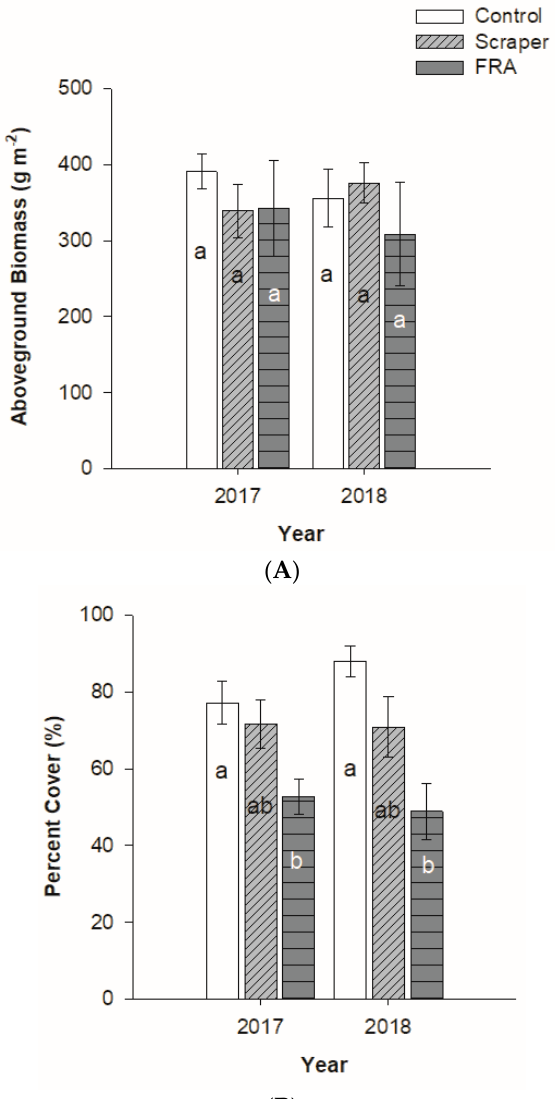
Figure 9. Mean aboveground biomass ( A ) and percent cover ( B ) of all non-pine herbaceous and woody species followed by standard error bars. Shared letters are not statistically different ( α = 0.05).